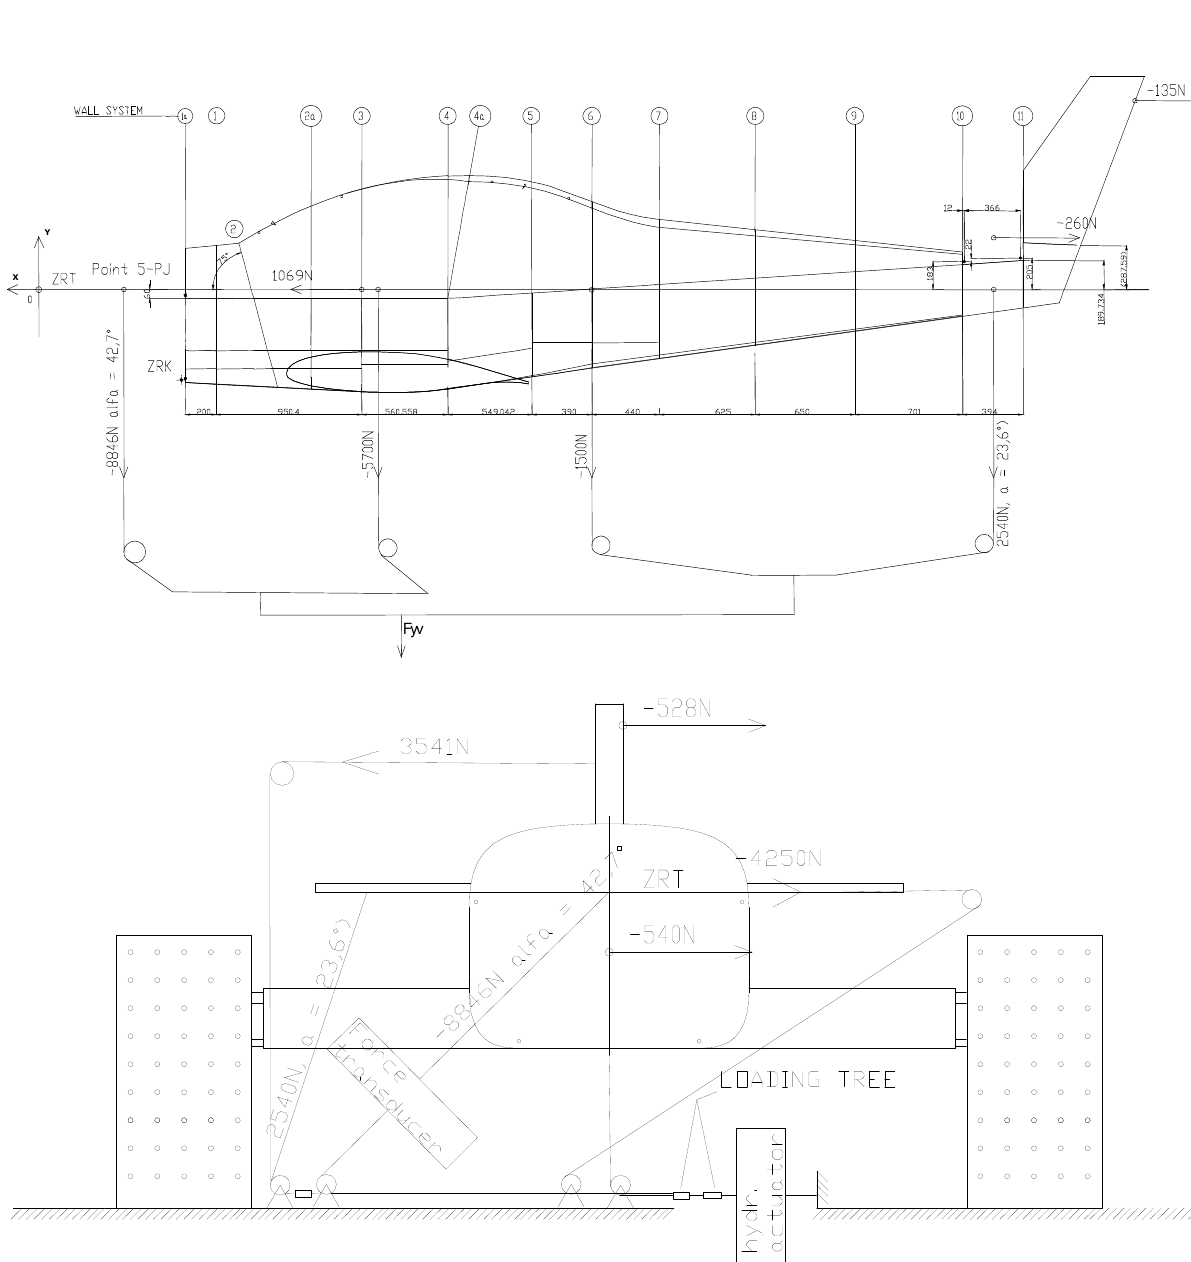
Fig 2. Proposed organization of the test – case manoeuvre of vertical